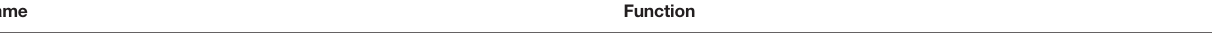
TABLE 2 | Roles of pulmonary surfactant components in viral